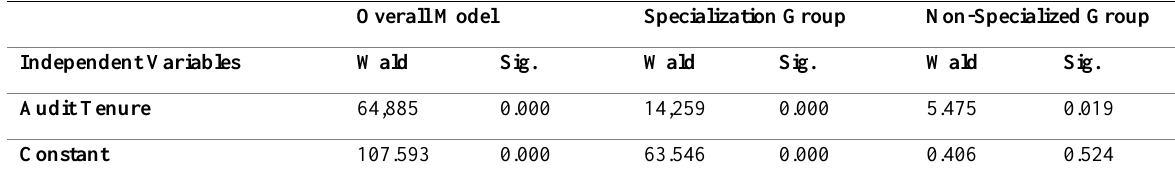
Table 8: Partial Hypothesis